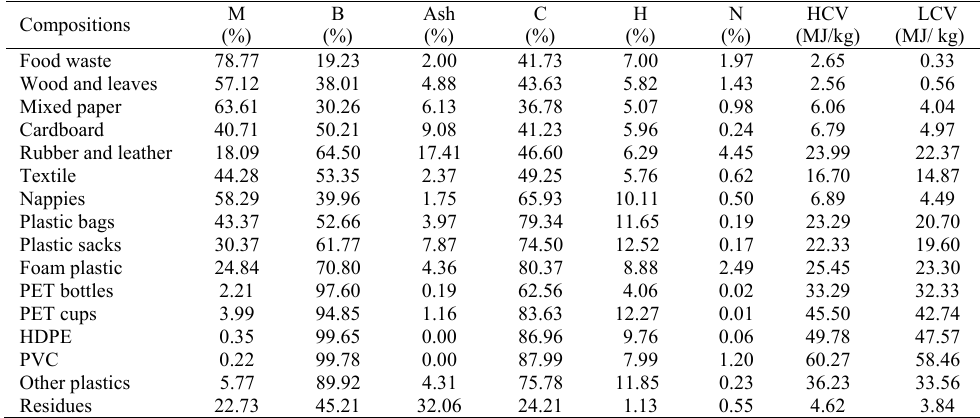
Table 4: Average results of chemical characteristics in MSW sub-compositions